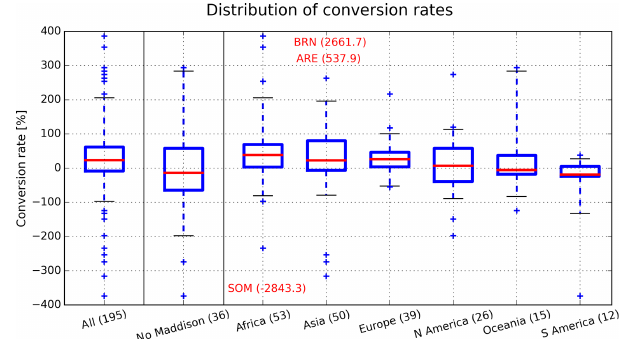
Figure 2. Statistical distribution of conversion rates used to convert 1990 GK USD to 2005 PPP USD. Most countries are close to the cross-country median conversion rate ( + 23.3%, red line in the left boxplot), while SOM (Somalia), ARE (United Arab Emirates), and BRN (Brunei) (stated in red; ARE, BRN, and SOM also appear in the “all” boxplot, ARE additionally in the “no Maddison” boxplot) are clear outliers with respective conversion rates shown in paren- theses. Whiskers display the 5 to 95% percentile range. Numbers in parentheses on the horizontal axis indicate the number of countries included in the respective boxplot.